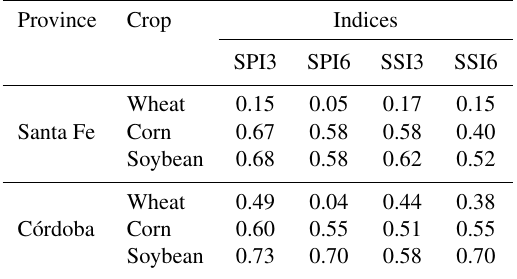
Table 3. Correlation coefficients of the annual detrended crop yield and the maximum or minimum index value for critical crop months (ON for wheat, DJ for corn, and JF for soybean). Maximum or min- imum index values are identified according to whether detrended annual crop yields are negative or